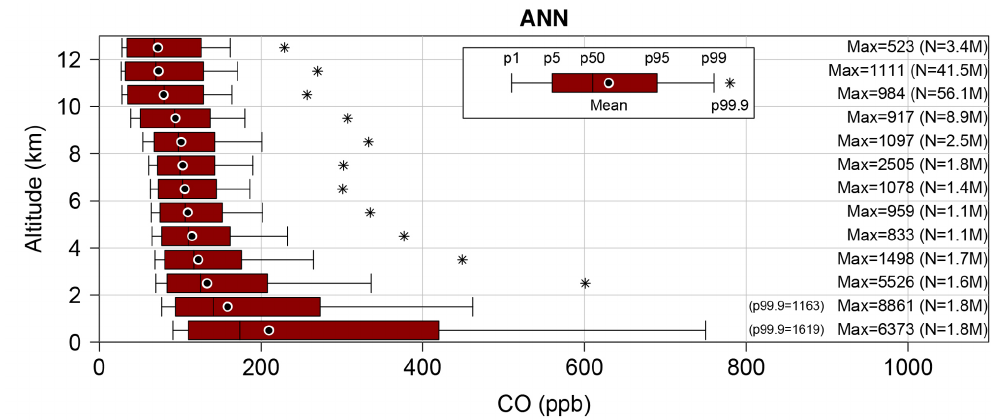
Figure 4. Distribution of CO mixing ratios measured by MOZAIC-IAGOS aircraft during the 2002–2017 period. Results are shown per 1km width layer, without any discrimination between troposphere and stratosphere ( N gives the number of points in millions; pX in the legend indicates the X th percentile of the